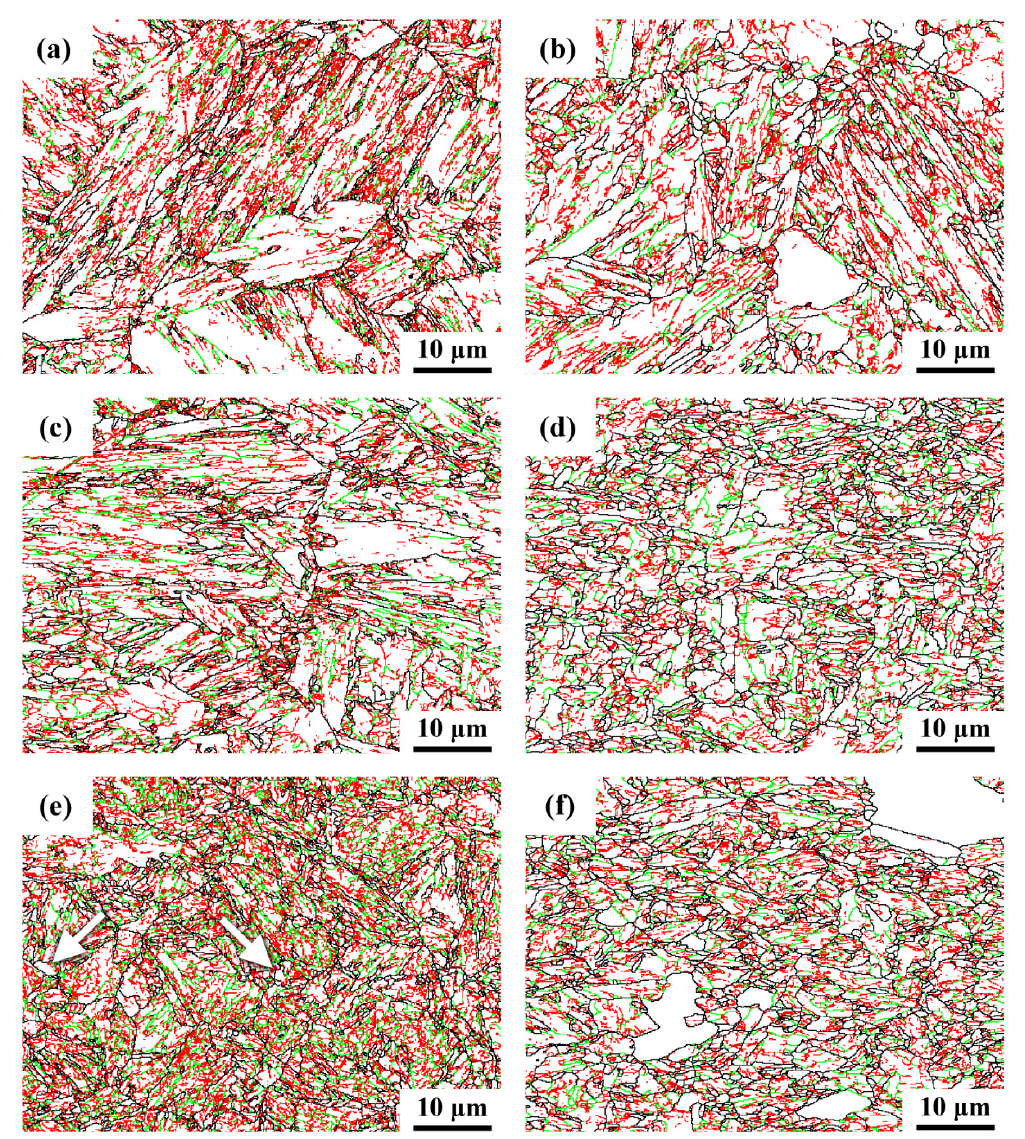
Figure 8. Grain boundary maps of the ( a ) W, ( b ) WP, ( c ) WP-800, ( d ) WP-800P, ( e ) WP-860 and ( f ) WP-860P specimens.